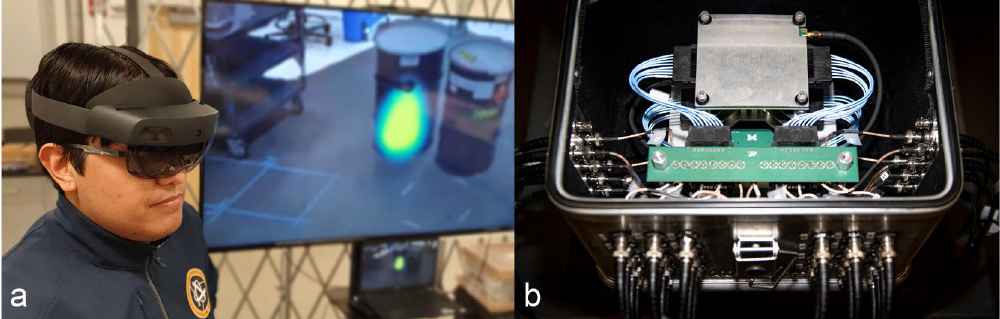
Figure 1. ( a ) Picture of a user wearing the Microsoft HoloLens2. The screen in the background depicts what the MR device shows the user - in this example an image of a hot spot over a barrel. ( b ) Picture of the (open) handheld dual particle imager (H2DPI), showing the top of the